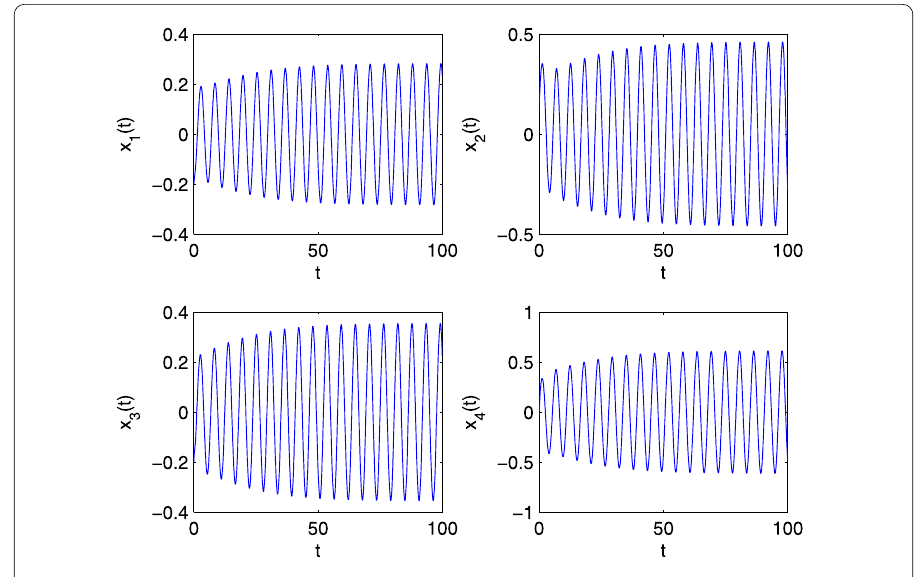
Figure 3 Time responses of system (5.1) with φ = 0.92, τ = 0.6 > τ 0 = 0.5421